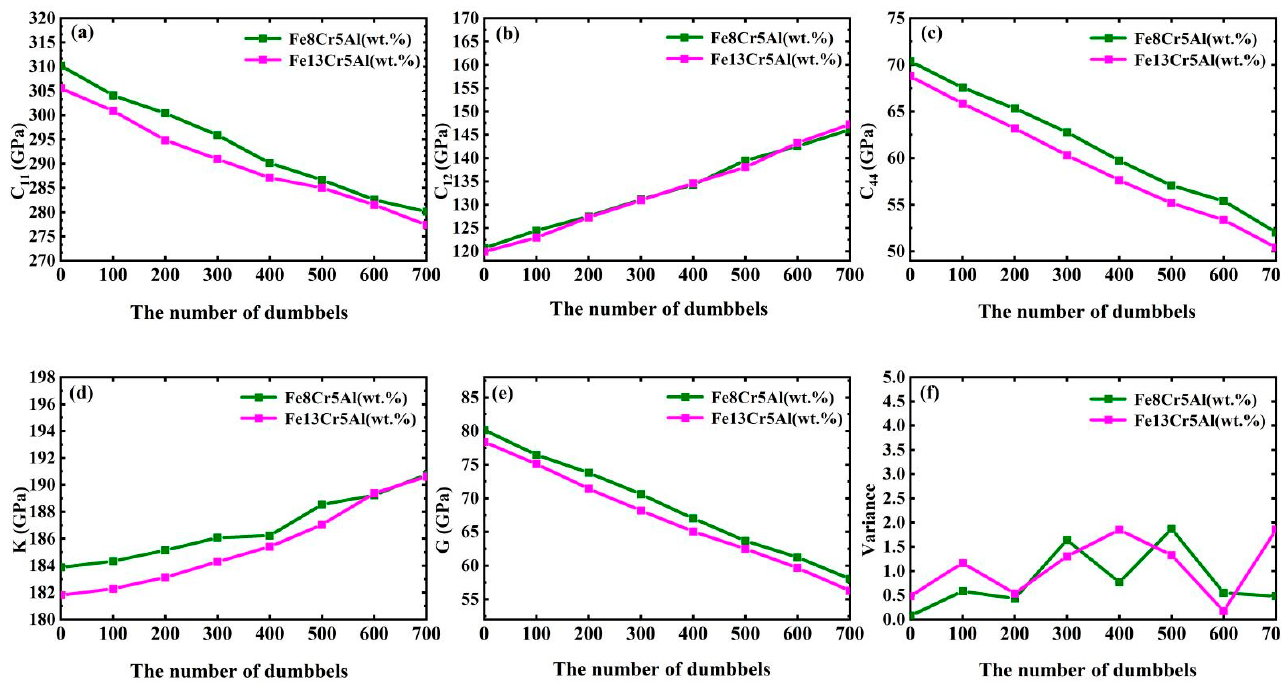
Figure 6 . ( a – e ) The dependence of C 11 , C 12 , C 44 , bulk modulus and shear modulus on number of dumbbell interstitials, ( f ) shows one example of statistical uncertainty for these elastic constants based on 50 simulations at 0 K.